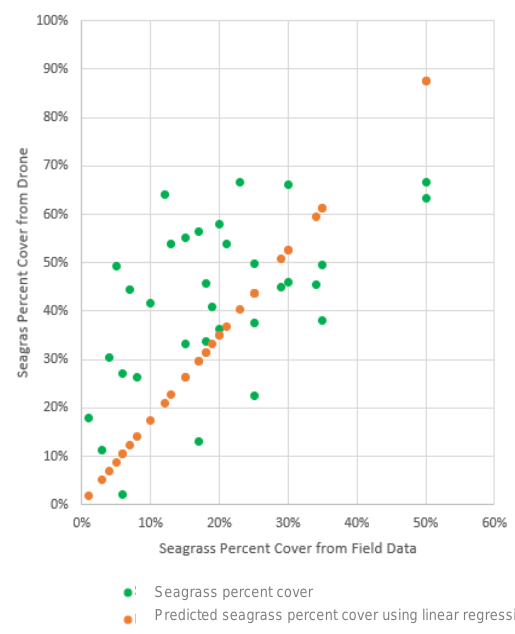
Figure 11. Linear relationship of seagrass percent cover from drone and field data in Station